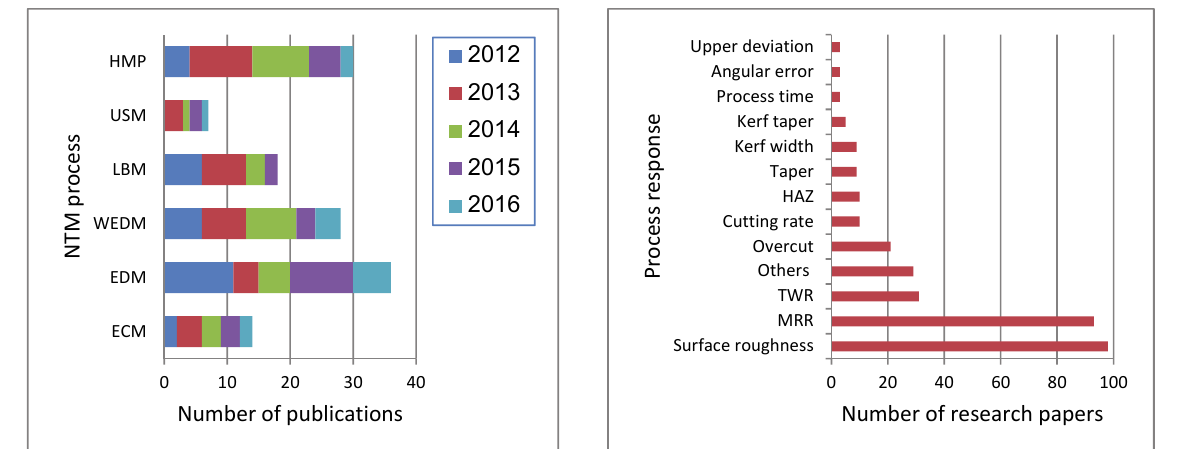
Fig. 8 Responses considered in the NTM processes